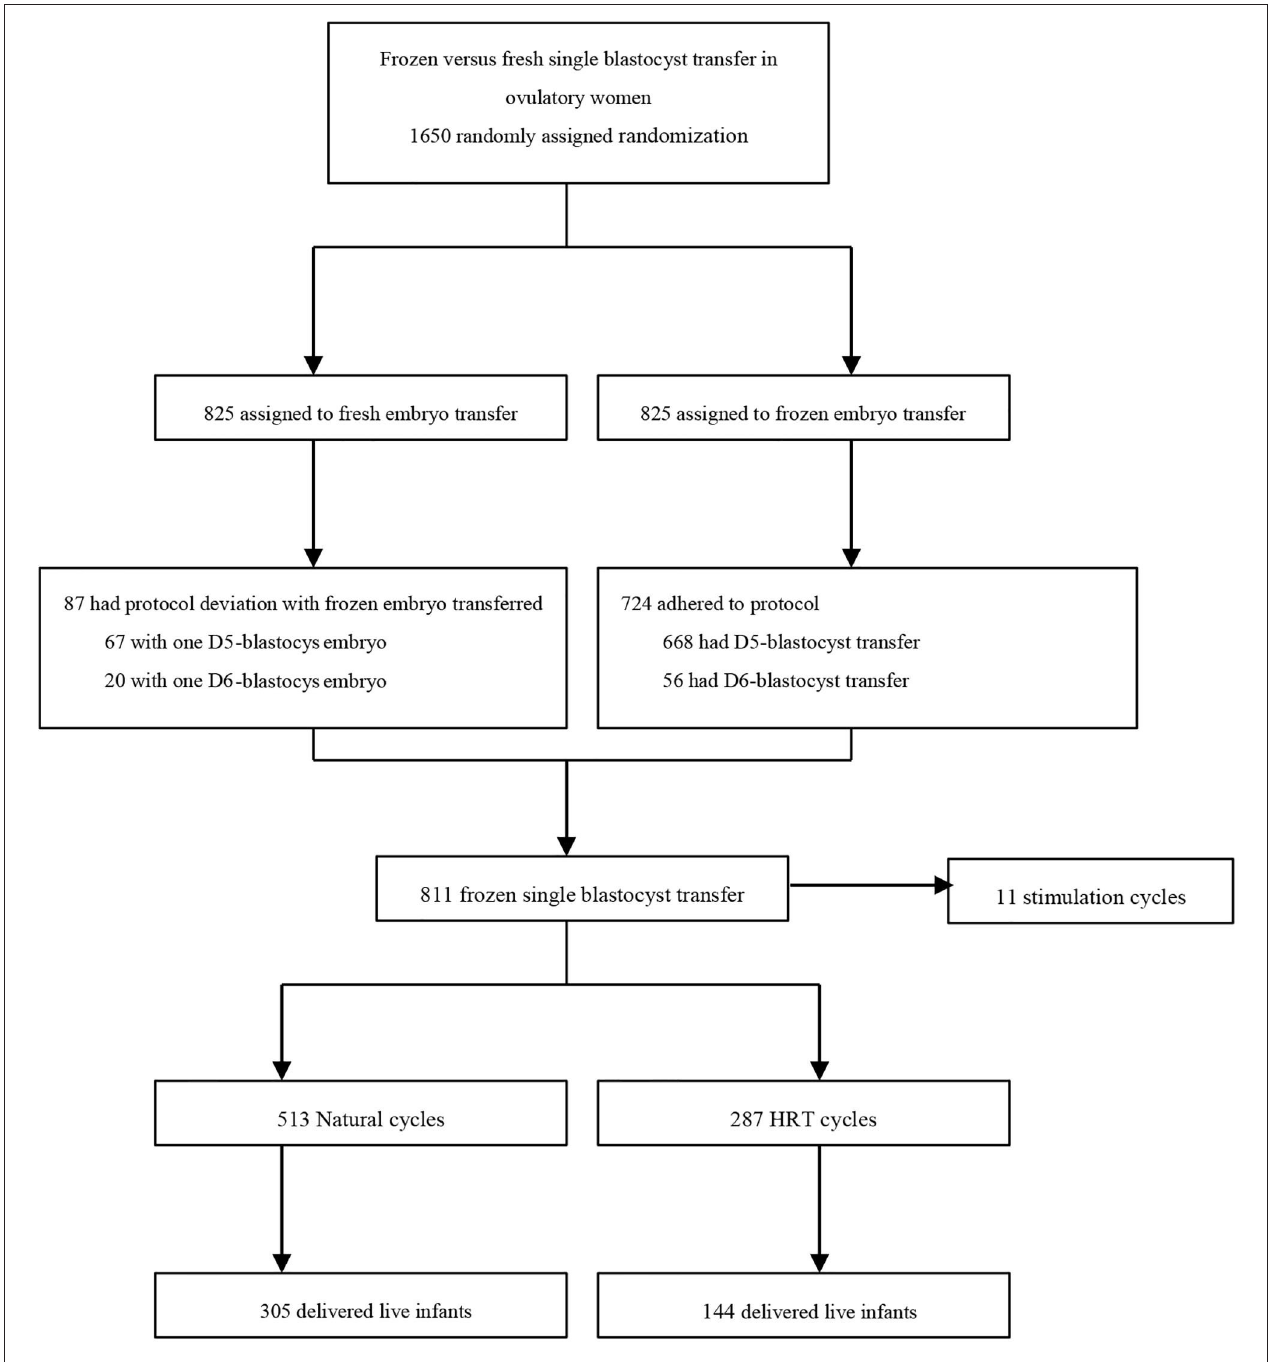
FIGURE 1 | Study flow